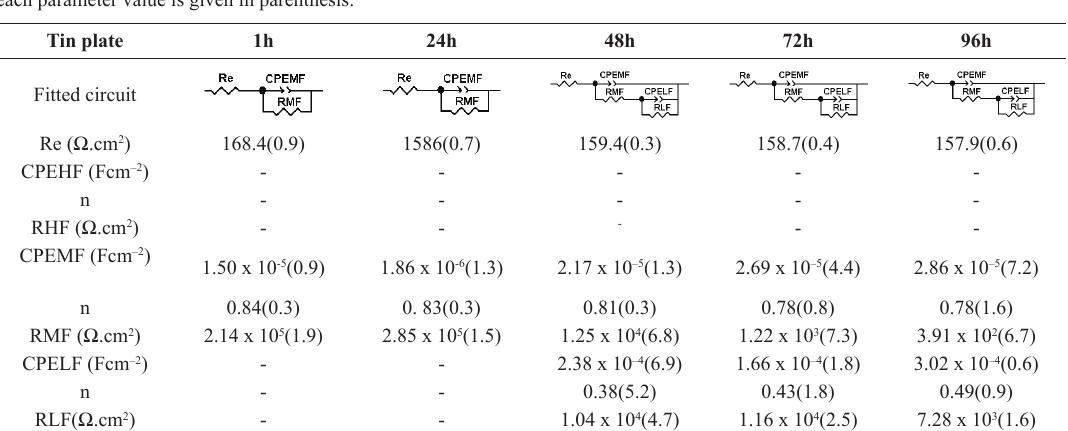
Table 4. Electrical elements fitted values for siloxane-PMMA with acetic acid up to 96 h of immersion in a 0.05M NaCl solution. The error % associated with each parameter value is given in parenthesis. Acetic acid Fitted